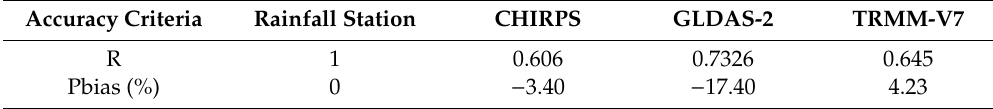
Table 3. Accuracy evaluation of grid precipitation data.